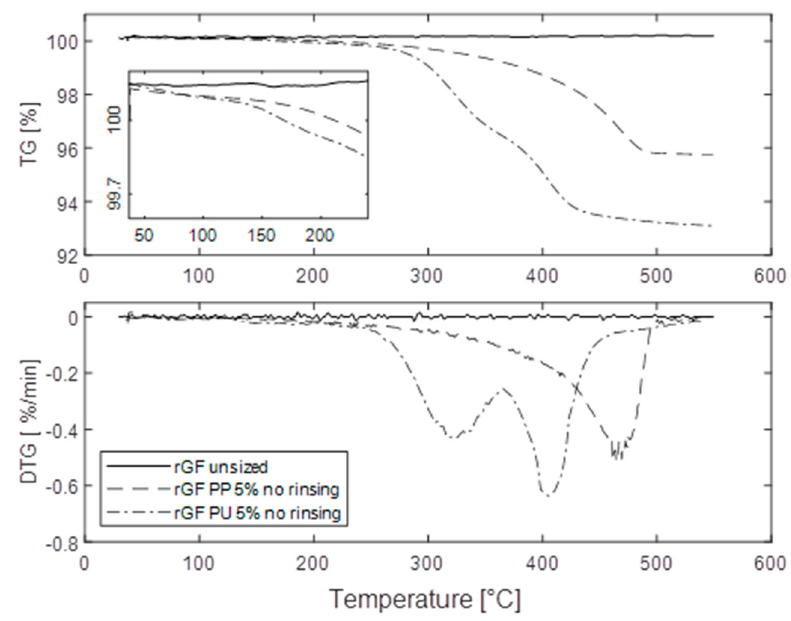
Figure 2. Examples of the rGF TG curves together with their derivatives (DTG curves) before sizing and after 5 w-% PP and PU sizing (without rinsing). and after 5 w-% PP and PU sizing (without